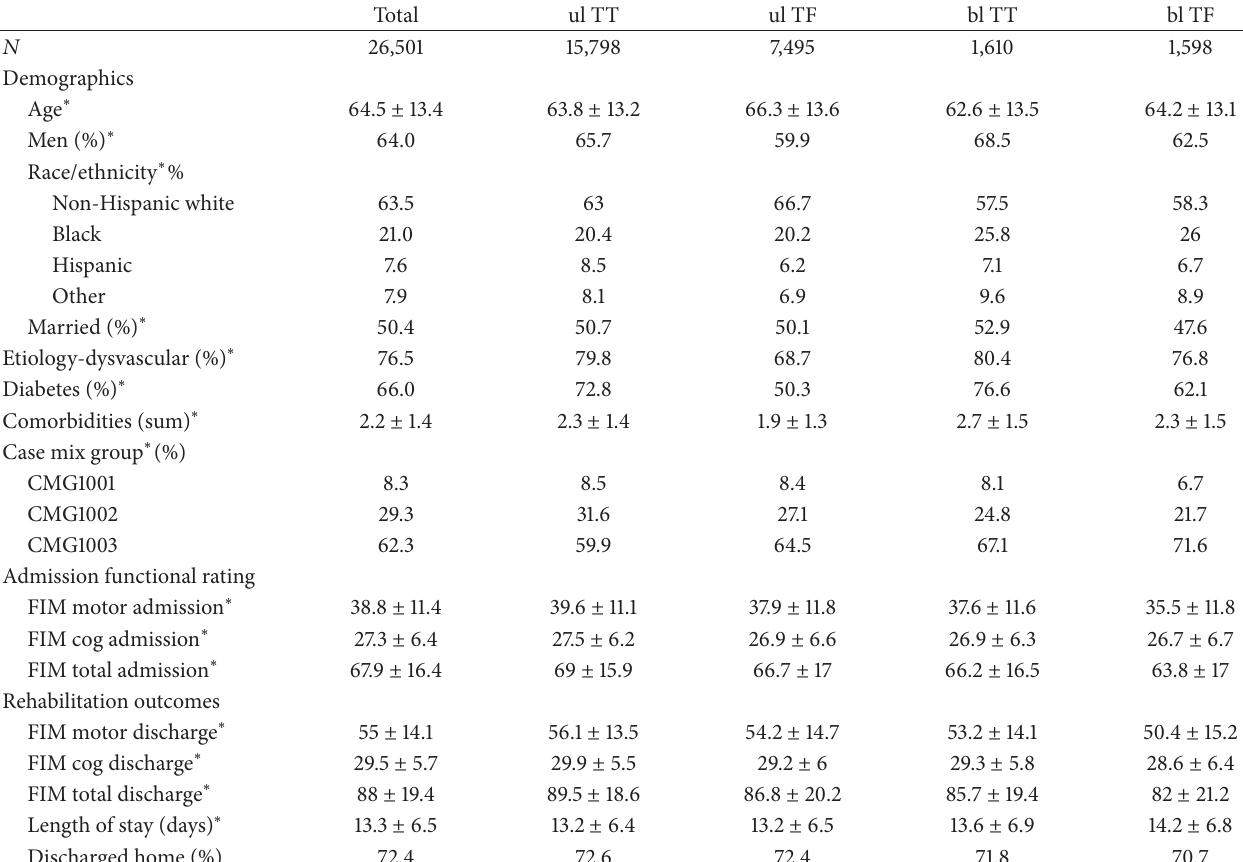
Table 1: Demographic characteristics and rehabilitation outcomes by amputation levels.